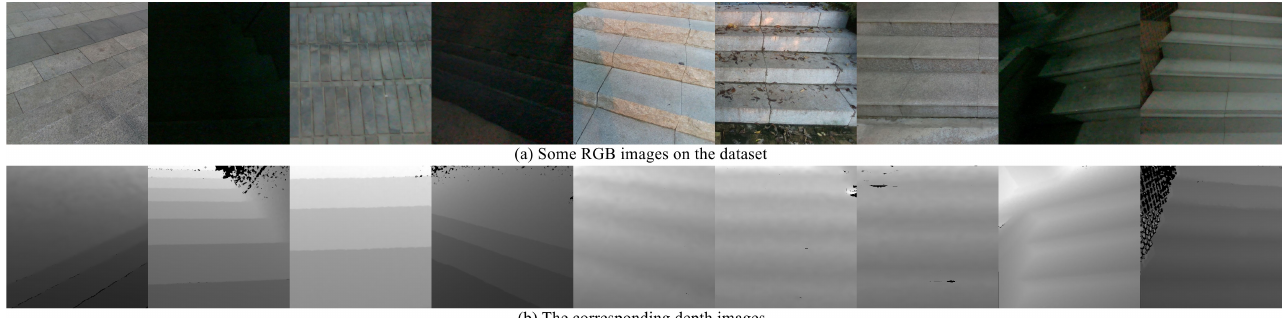
Figure 1. Some RGB images and the corresponding depth images on the dataset. The RGB image and the corresponding depth image are complementary to some